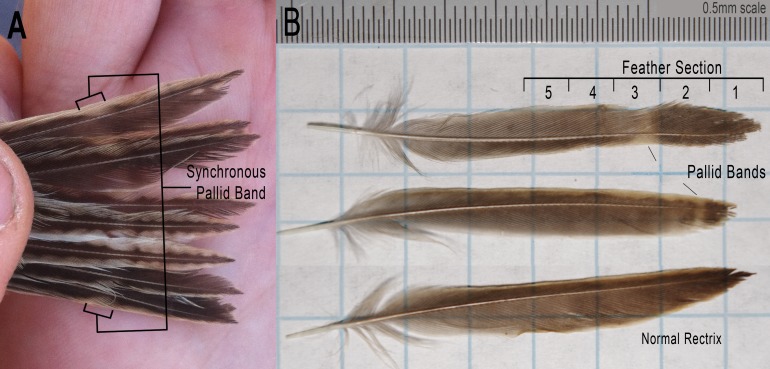
Photographs of Grasshopper Sparrow rectrices from the Grazinglands Research Laboratory.(A) Shows an individual tail with a synchronous pallid band. (B) Illustrates the sections sampled from the rectrices of juvenile Grasshopper Sparrows. Sampling was constrained to provide a minimum of 0.2–0.3 mg from each section. Shown are two examples of feathers with fault bars (top) and one of normal growth (bottom). Photograph 1A by W. Alice Boyle; photograph 1B by Jeremy D. Ross.